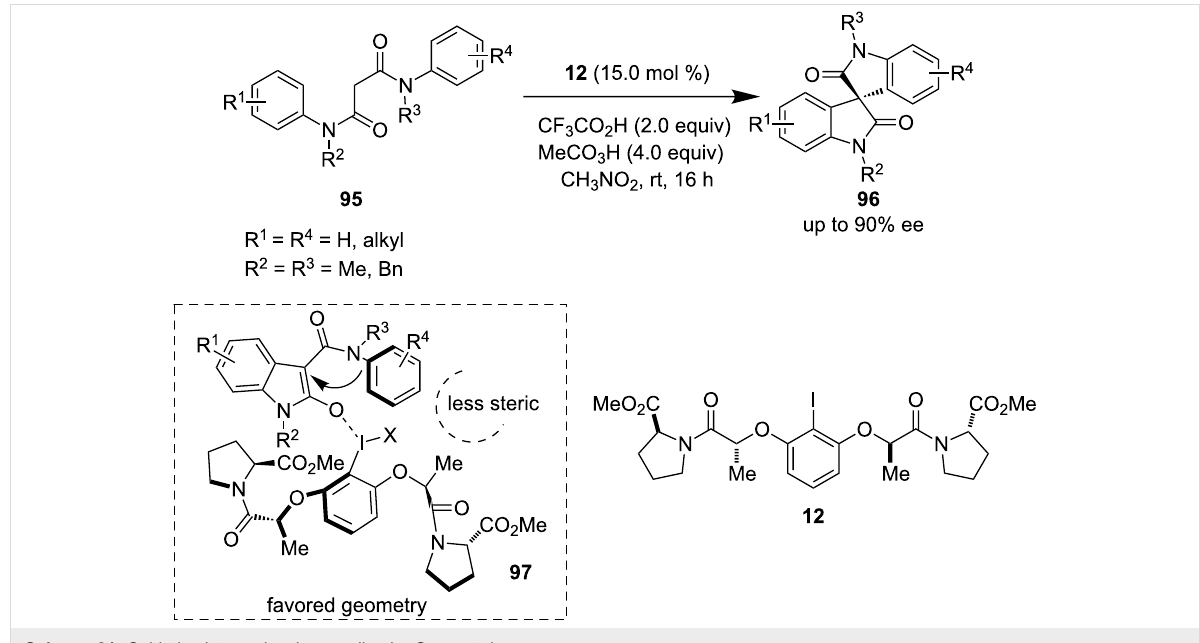
Scheme 21: Oxidative Intramolecular coupling by Gong et al.